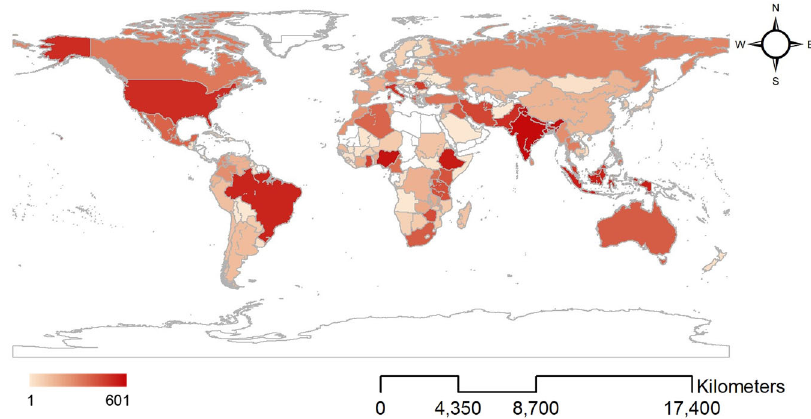
Fig. 2 Geographical distribution of respondents by country of citizenship. The darker the color the higher number of